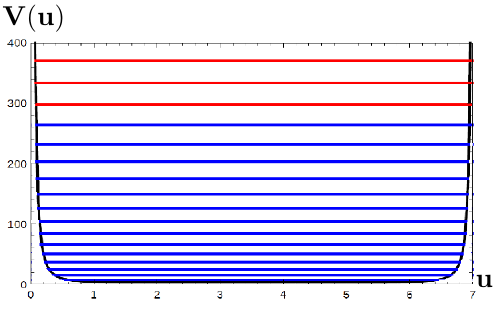
Figure 7. Plot of di(cid:11)erent roots in the poten- tial V ( u ) for n = 10 spikes. The top three levels which we have used in our calculations, starting from top have h = 366 : 6 (red), h = 326 (red) & h = 290 : 2 (red) respectively.